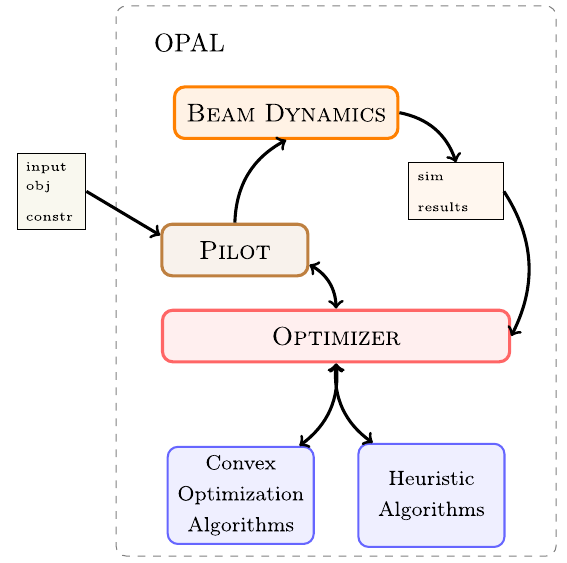
FIG. 1. Multiobjective framework: the pilot (master) solves the optimization problem specified in the input file by coordinating optimizer algorithms and workers running a forward